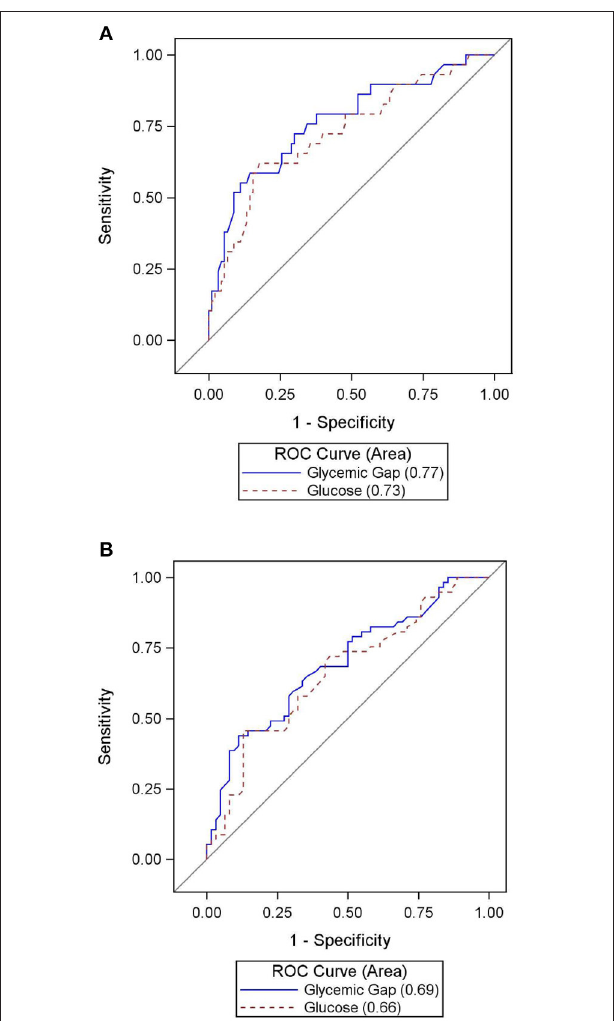
FIGURE 2 | (A) Accuracy of admission glucose vs. admission glycemic gap in predicting in-hospital mortality. (B) Accuracy of admission glucose vs. admission glycemic gap in predicting poor composite outcome.